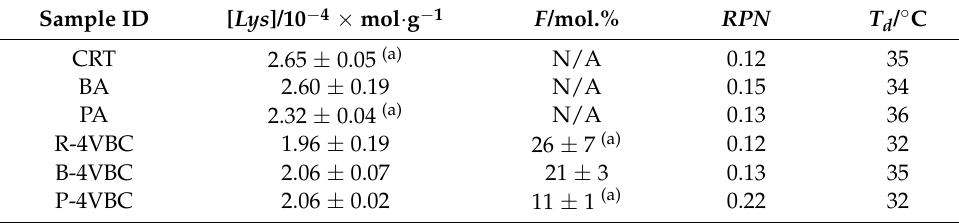
Table 1. Lysine content, degree of functionalisation ( F ), ratio of positive to negative magnitude ( RPN ), and denaturation temperature ( T d ) of native and functionalised collagen samples. CRT—collagen extracted from rat tails, BA—bovine atelocollagen, PA—porcine atelocollagen, R-4VBC—4VBC-functionalised CRT, B-4VBC—4VBC-functionalised BA, P-4VBC—4VBC-functionalised PA, N/A—not applicable.